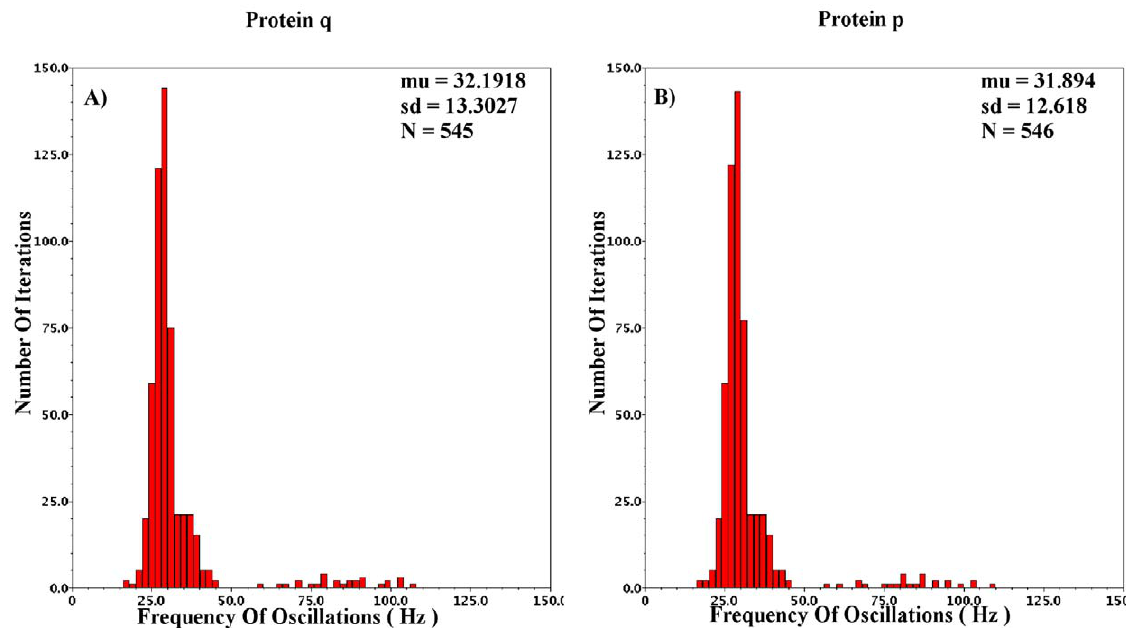
Figure 21. Monte Carlo Analysis for the two variable gene-protein regulatory Log-Domain circuit. Graphs A and B correspond to the various frequencies of protein q and p, respectively, throughout the analysis. 600 runs have been performed resulting to a successful percentage rate greater than 90 % .